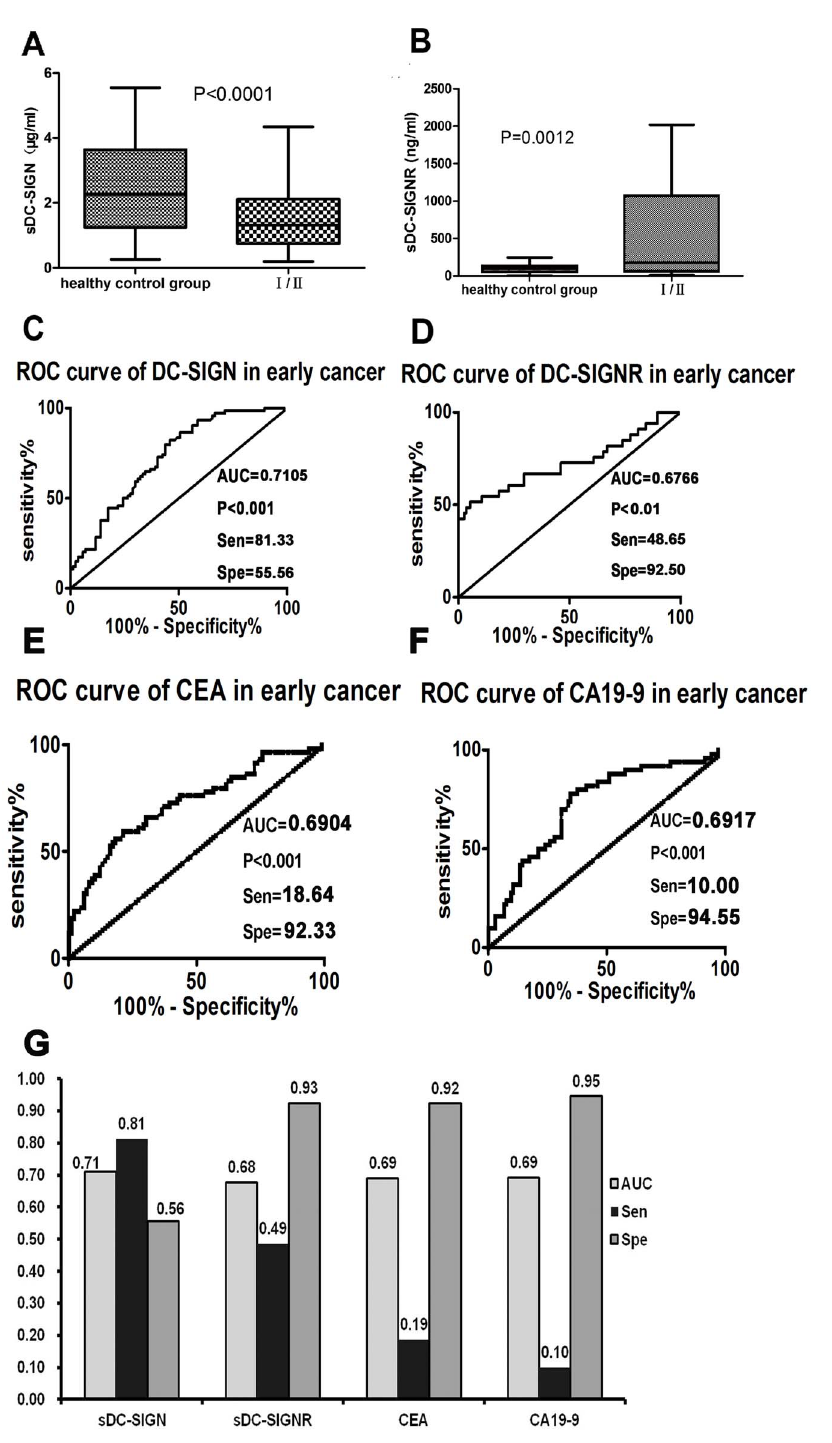
Fig. 2. The early diagnostic values of sDC-SIGN and sDC-SIGNR in stage I/II colon cancer patients. A–B : Both sDC-SIGN and sDC-SIGNR levels from early colon cancer patients. Stage I/II patients were significantly different from healthy people, P , 0.01. sDC-SIGN is lower than in the healthy control, while sDC- SIGNR is higher. C–D : In the stage I/II patients, sDC-SIGN and sDC-SIGNR had a significant diagnostic value (P , 0.01). The cut-off concentrations of DC-SIGN and DC-SIGNR were less than 2.211 m g/ml and more